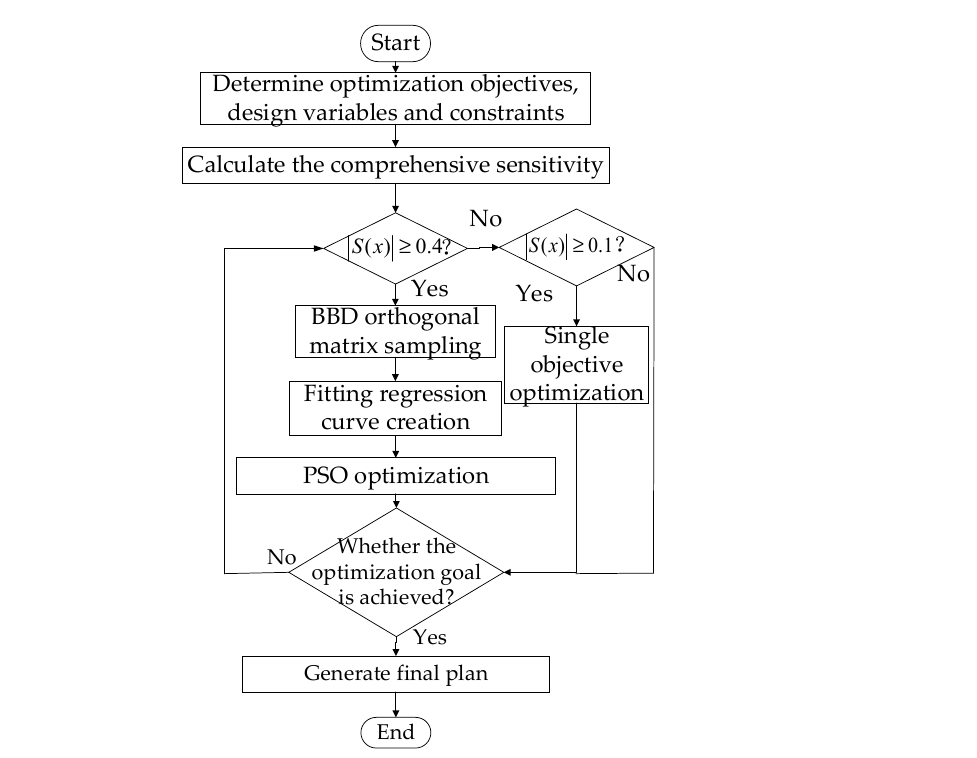
Figure 9. Dimension structure of STMLPMVG.